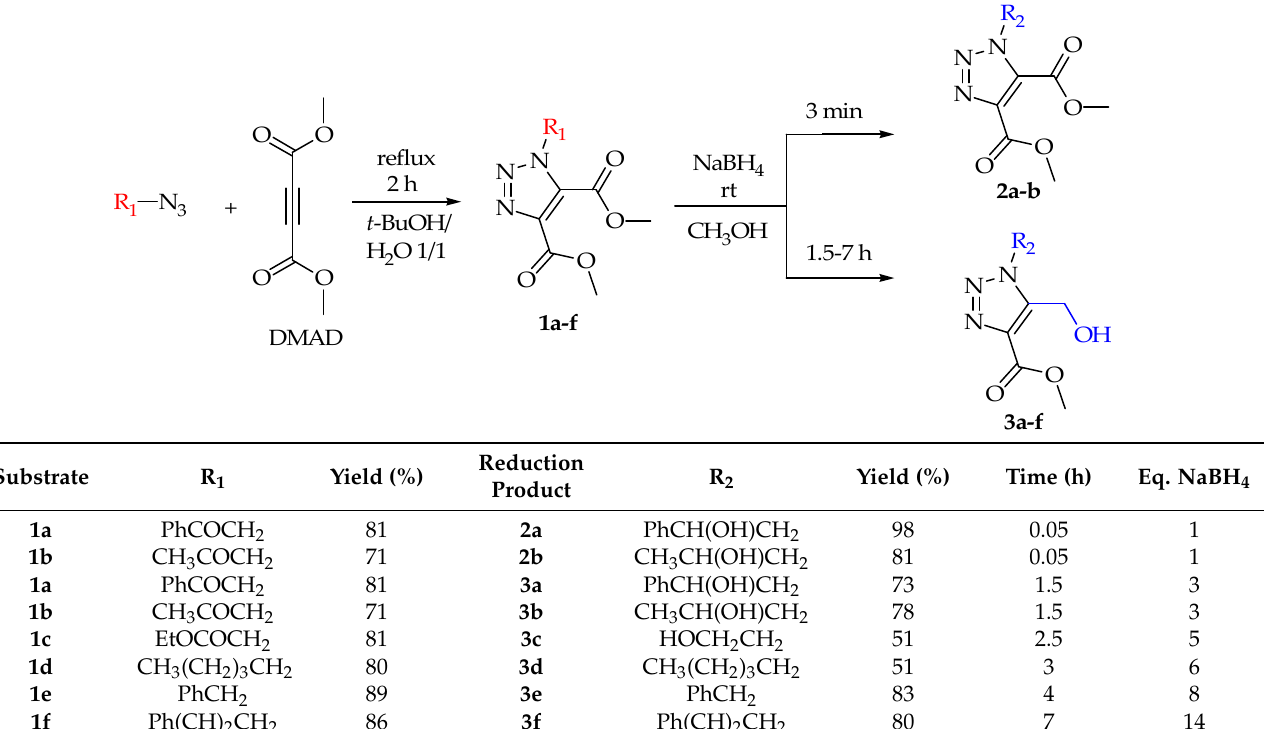
Table 1. Preparation of dimethyl 1H -1,2,3-triazole-4,5-dicarboxylates from organic azides and dimethyl acetylenedicarboxylate (DMAD) and their reduction with sodium borohydride (NaBH 4 ).